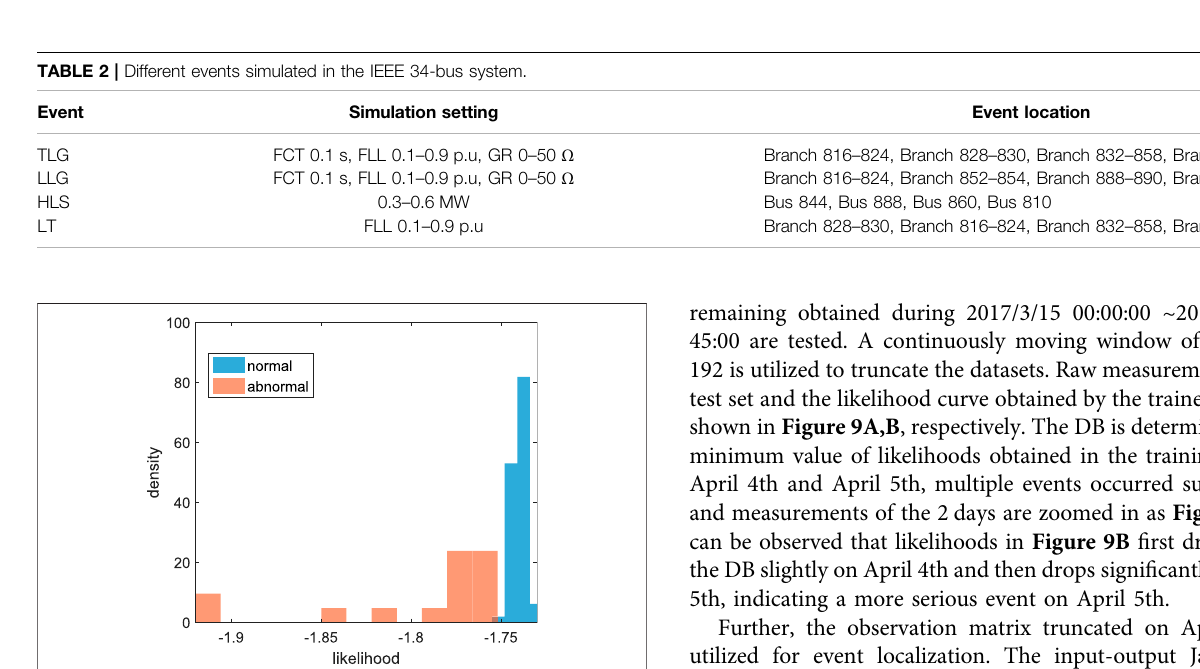
FIGURE 7 | The fl owchart of the framework for event detection, localization, and classi fi cation.